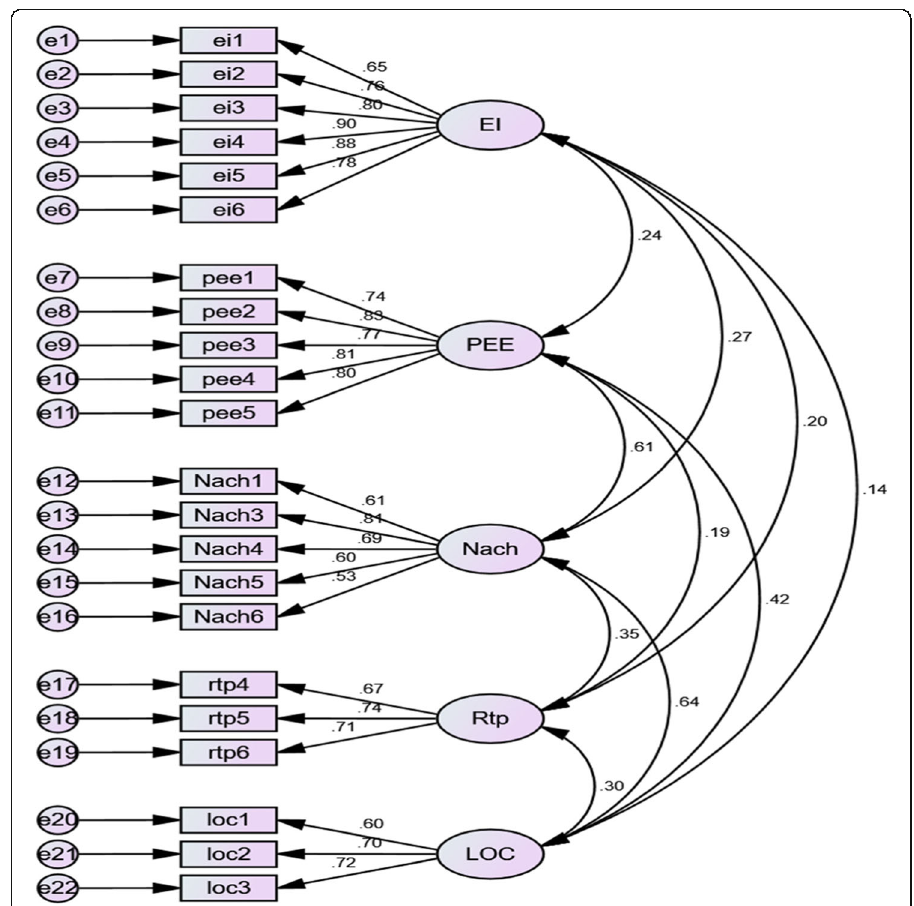
Fig. 2 Node diagram for CFA. Ei, entrepreneurial goal intention; pee effects of entrepreneurship education, nach need for achievement, rtp risk-taking propensity, loc internal locus of control